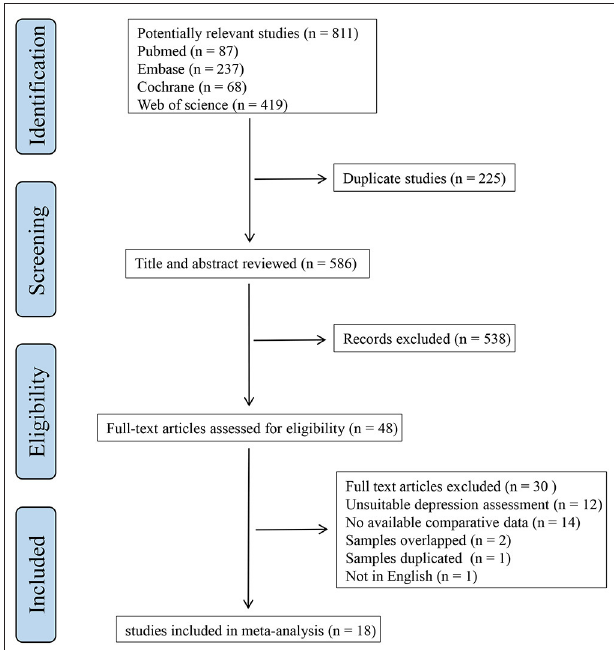
FIGURE 1 | Flowchart of literature search and